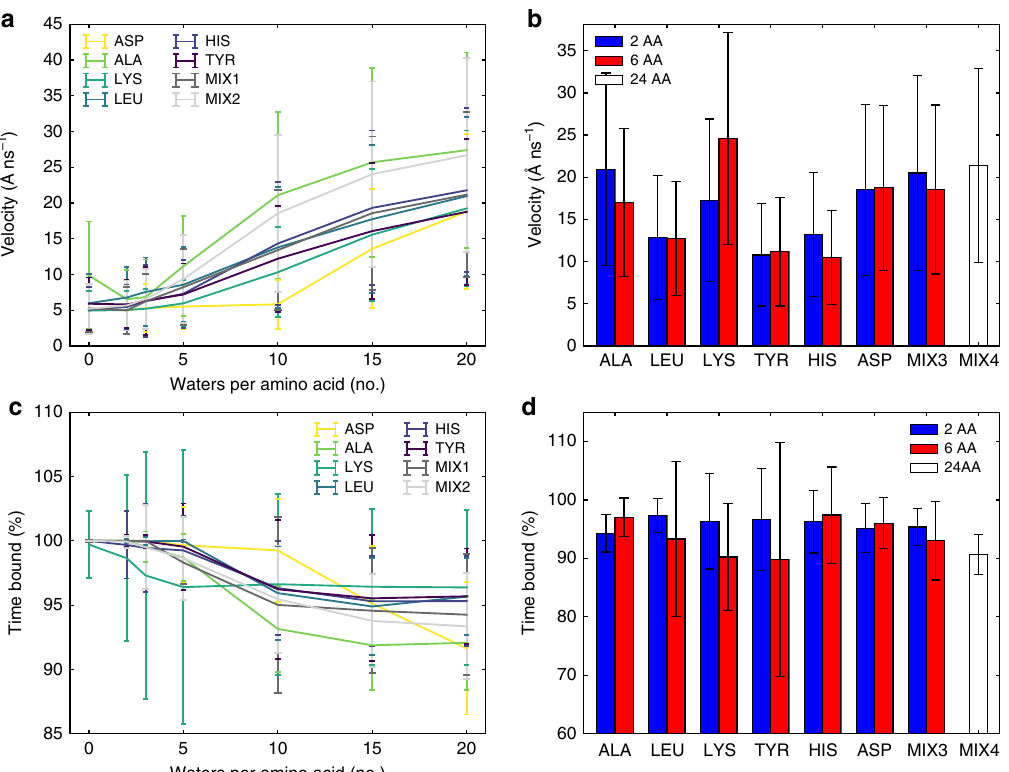
Fig. 4 Adsorbed amino acids and peptides remain mobile. a Velocities of adsorbed amino acids as a function of their hydration (number of water molecules per amino acid). b Velocities of adsorbed di-peptides, hexa-peptides, and 24-mers in a fully hydrated system. c Time bound of adsorbed amino acids after a fi rst adsorption event as a function of their hydration (number of water molecules per amino acid). d Time bound of adsorbed amino acids after a fi